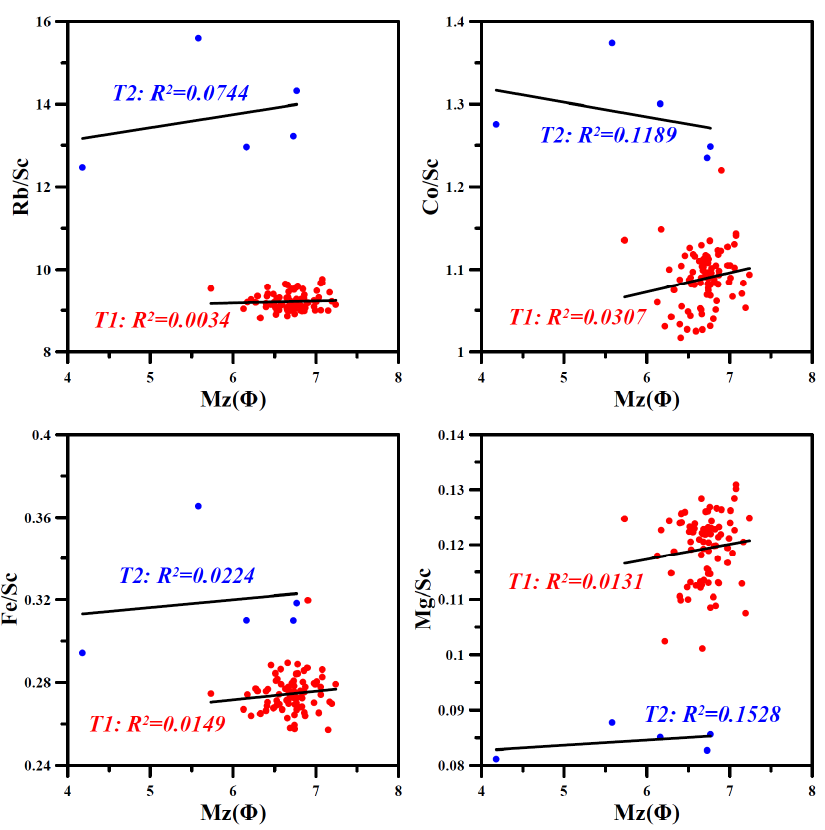
Figure 8. Correlation between Rb/Sc, Co/Sc, Fe/Sc, Mg/Sc, and Mz.